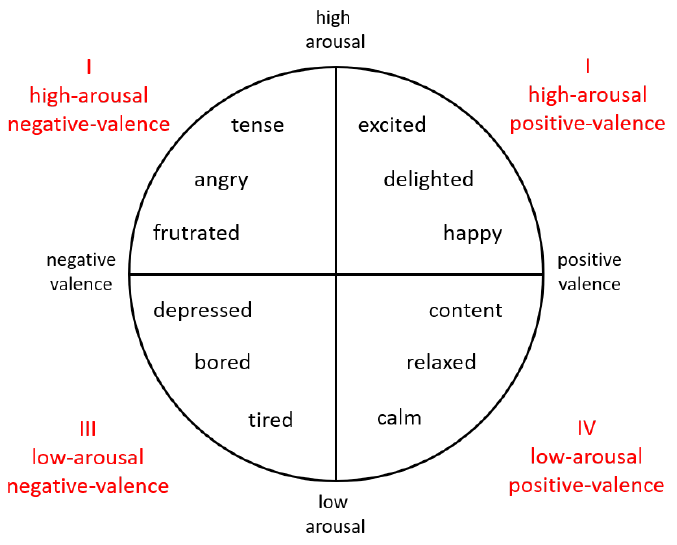
Figure 2. Russell’s two-dimensional circumplex model showing the distribution of